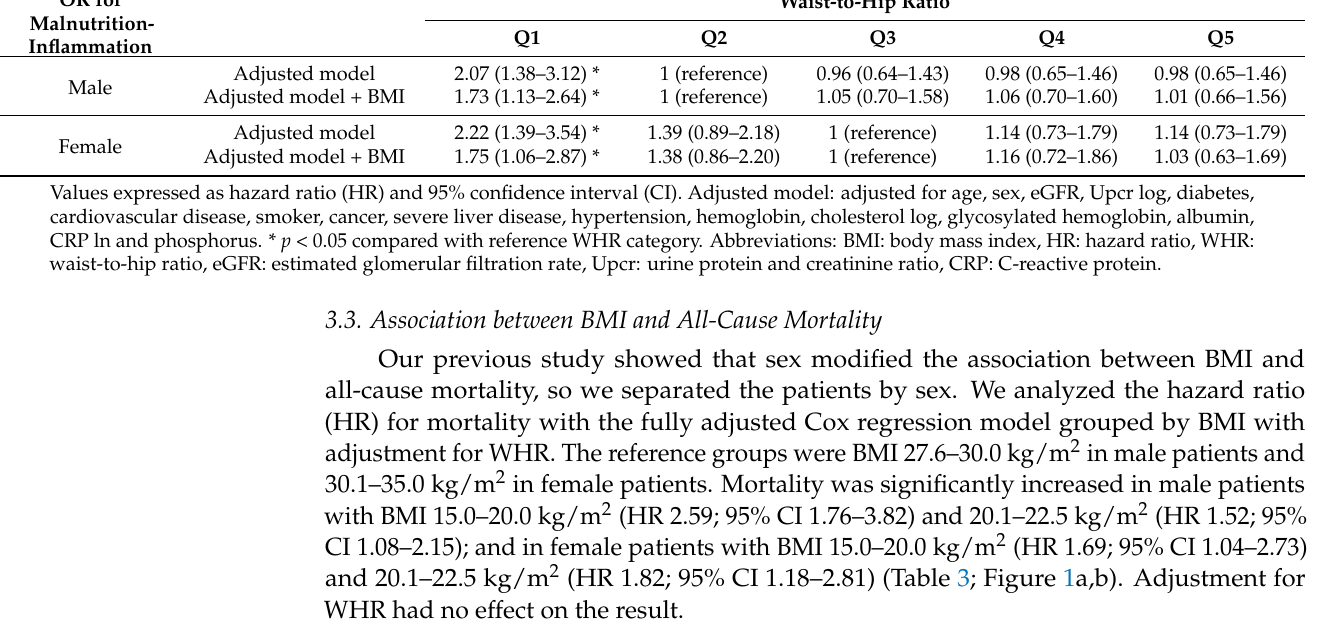
Table 3. HRs for mortality according to